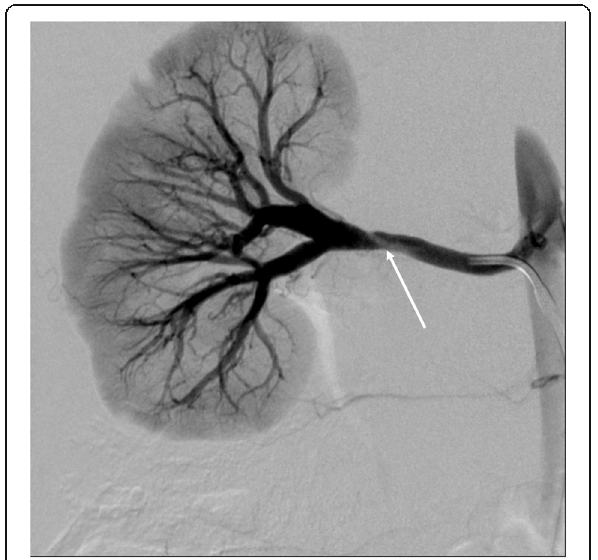
Fig. 7 Distal embolic phenomenon. Post right renal artery angioplasty demonstrating focal segmental renal artery occlusion (short arrow) with absent perfusion consistent with a distal renal thrombo-embolic event post angioplasty (long